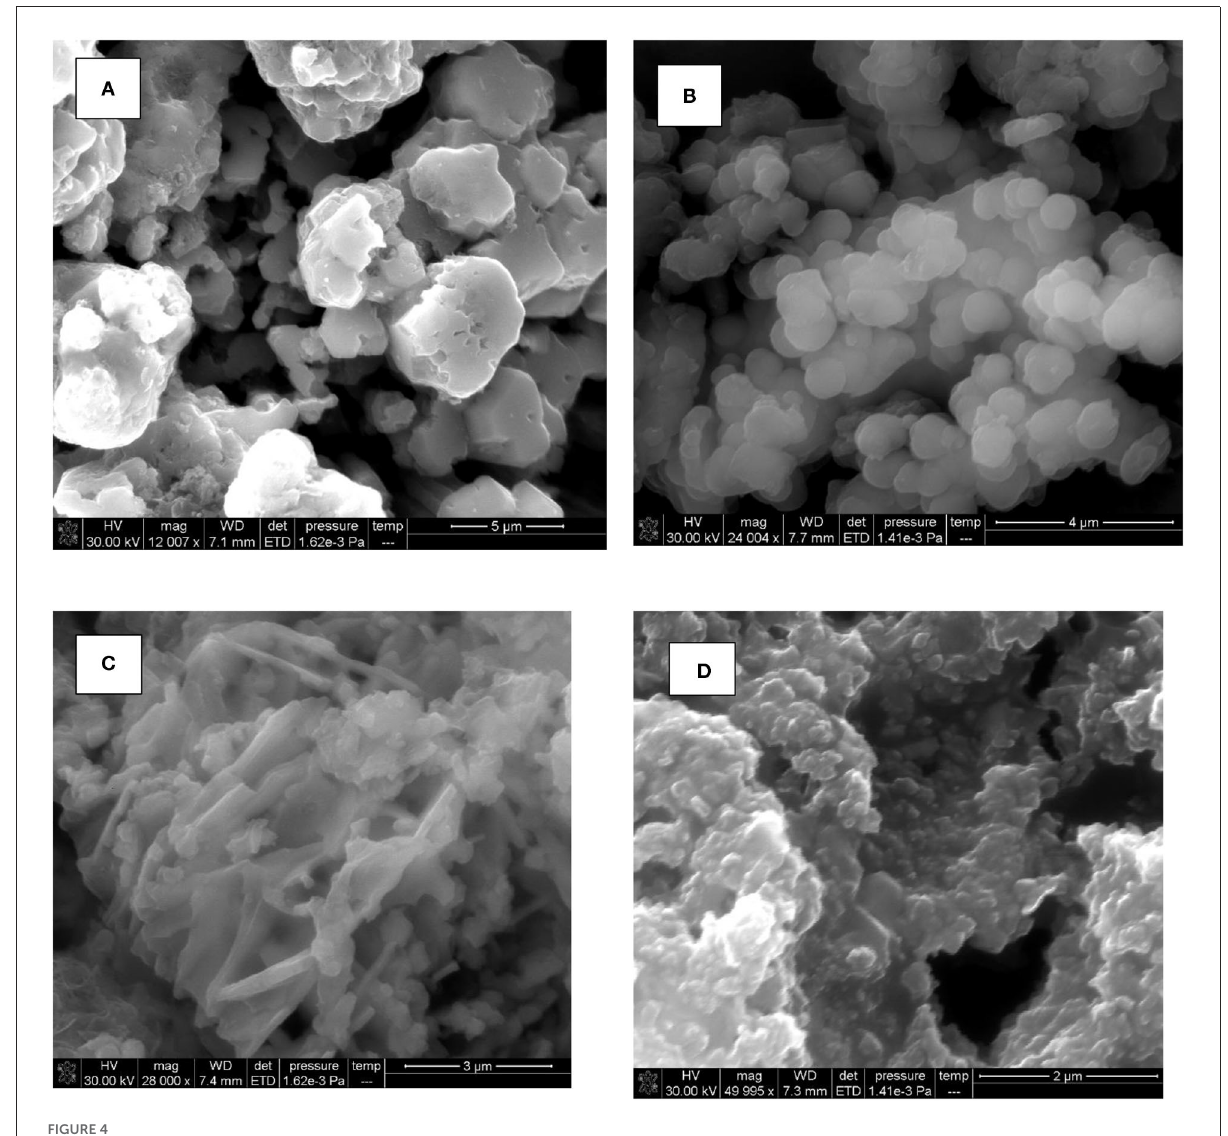
FIGURE4 SEM images of (A) CuO, (B) PANI/CuO, (C) ZnO, and (D)